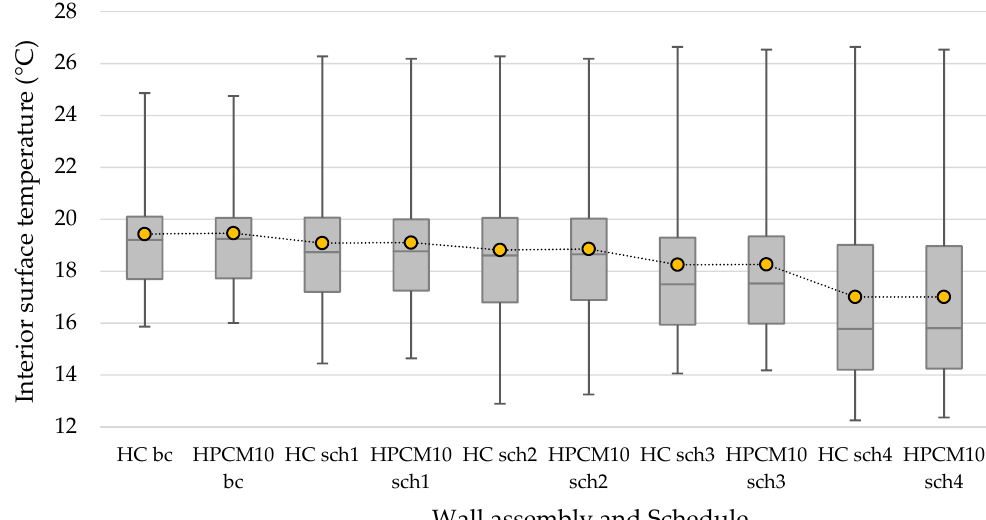
Figure 16. Distribution of interior surface temperatures of hempcrete (HC) and HPCM10 under five schedules.